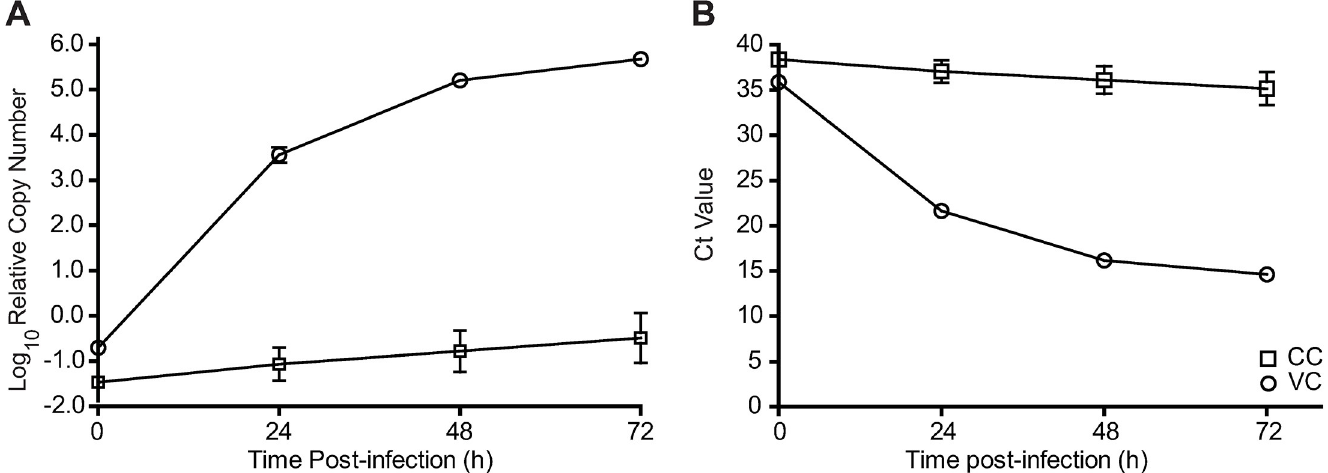
Fig 2. Replication kinetics of MV. Vero cells were seeded in 96-well plate. The next day, monolayers were infected with 500 TCID 50 per well of low-passage Edmonston MV or mock infected with media only. The procedure followed the standard MN-RT-qPCR protocol except in absence of antibodies. At the indicated times, cell lysates were prepared using Bio-Rad SPR and subjected to one-step SYBR green RT-qPCR. Each point represents the mean of 8 replicates of measles-infected Vero cells ( ◯ ) or uninfected Vero cells ( ☐ ) for (A) relative RNA copy numbers and (B) Ct value.